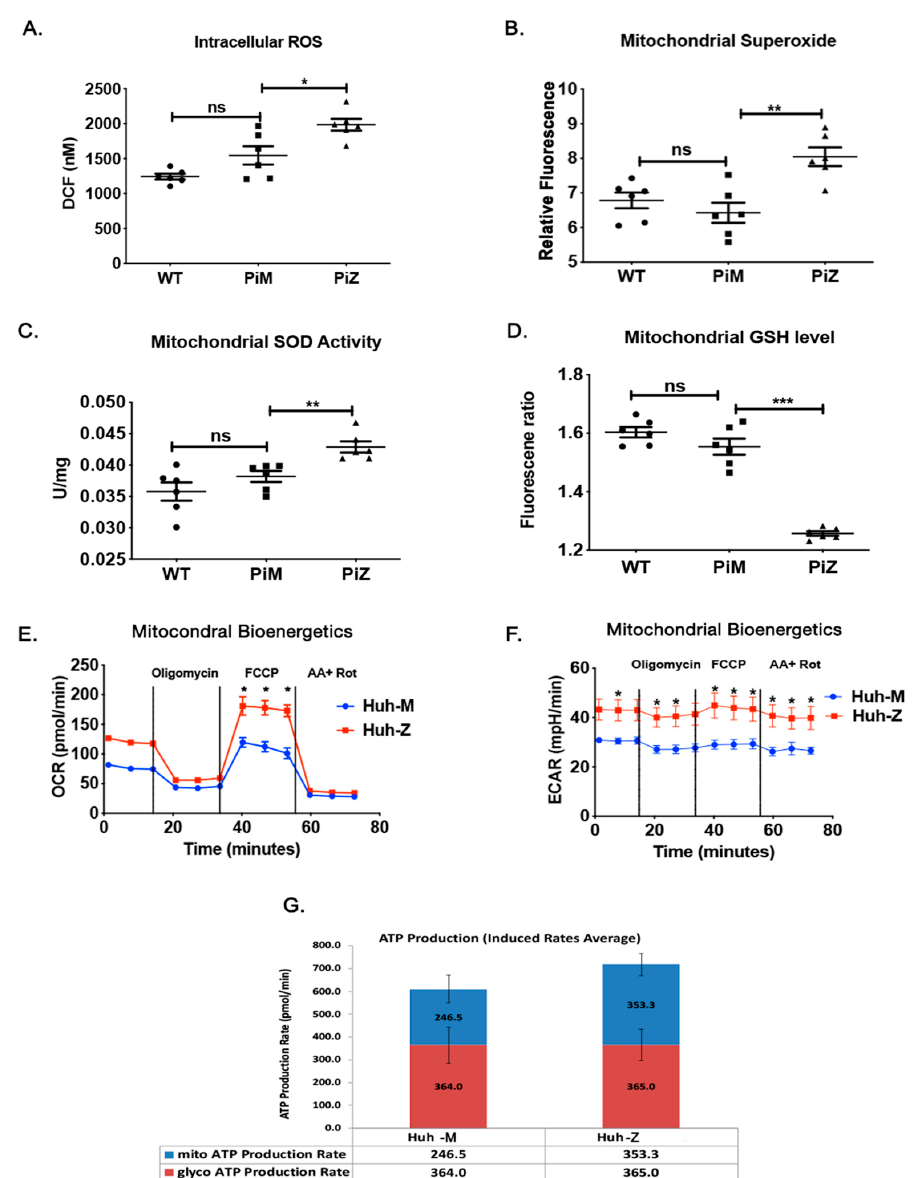
Figure 3. ZAAT-induced hepatic mitochondrial dysfunction. ( A ) Hepatic intracellular ROS levels in wild-type, Pi*M, and Pi*Z mice by measuring the DCF fluorescent signal in fresh liver sections. ( B ) Hepatic mitochondrial superoxide levels in wild-type, Pi*M, and Pi*Z mice. ( C ) Activity of hepatic mitochondrial superoxide dismutase (SOD) enzyme measured by superoxide dismutase assay kit in wild-type, Pi*M, and Pi*Z mice. ( D ) Hepatic mitochondrial glutathione (GSH) levels of wild-type, Pi*M, and Pi*Z mice. ( E , F ) The OCR (oxygen consumption rate) and ECAR (extracellular acidification rate) in control and ZAAT-expressing Huh7.5 cells measured by Seahorse assay followed by ( G ) the ATP production rate. ns nonsignificant, * p < 0.05, ** p < 0.001, *** p <